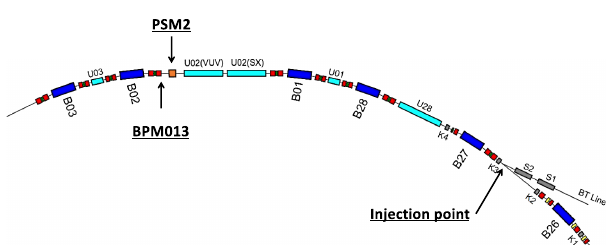
FIG. 18. Schematic view of the lattice configuration from the injection point to PSM2 in the PF ring. BPM013 was used for turn-by-turn oscillation measurements of the stored beam. The blue rectangles represent bending magnets, the red ones represent quadrupole magnets, and the light-blue ones